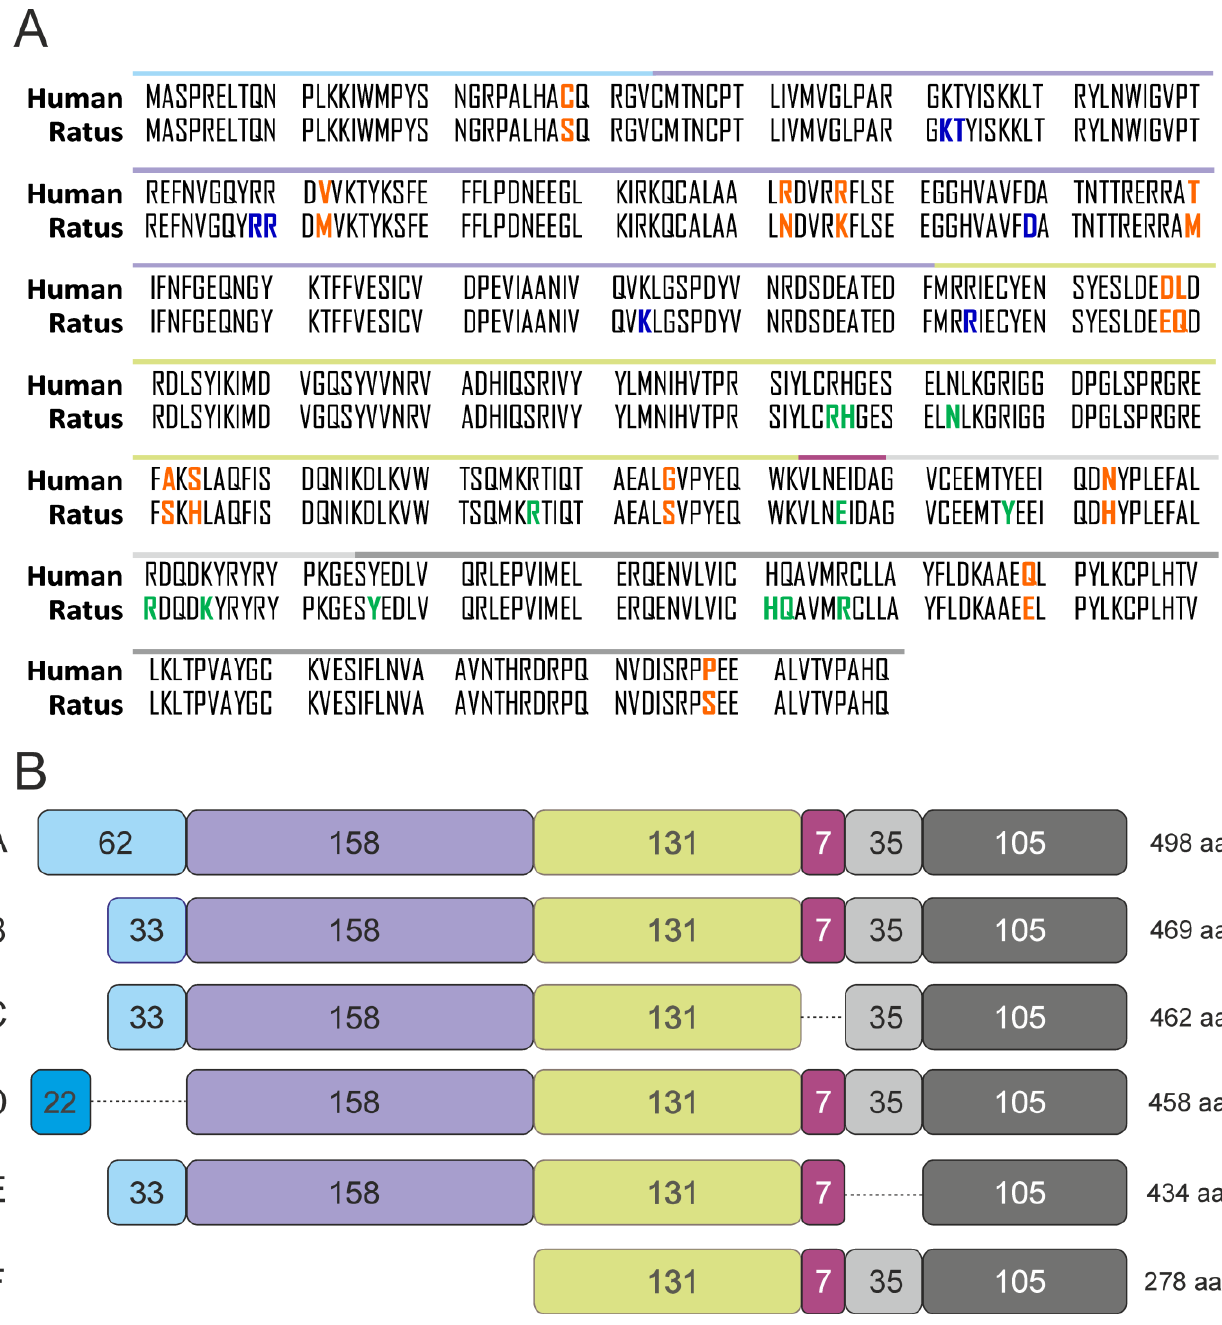
Figure 4. Isoforms of PFKFB4 protein. ( A ) Comparison of the PFKFB4 protein sequence of humans (NCBI Reference Sequence: NP_004558.1) and Rattus Norvegicus (NCBI Reference Sequence: NP_062206.1). Differences in amino acid sequence are marked in orange. Amino acids of the 6-PF-2-K active site were colored in blue and amino acids of the Fru-2,6-P2ase active site were colored in green. Based on the Hasemann et al. Kinase domain from 30th to 249th amino acid, phosphatase domain from 252nd to 438th amino acid. Colored lines above the one-letter amino acid abbreviations reflect corresponding parts of protein structure presented in panel B (in relation to isoform B). ( B ) Schematic representation of PFKFB4 protein isoforms. The amino acid sequences were obtained from the NCBI Protein database with the following codes: isoform A (NP_001304063.1), isoform B (NP_004558.1), isoform C (NP_001304064.1), isoform D (NP_001304065.1), isoform E (NP_001304066.1), isoform F (NP_001304067.1).